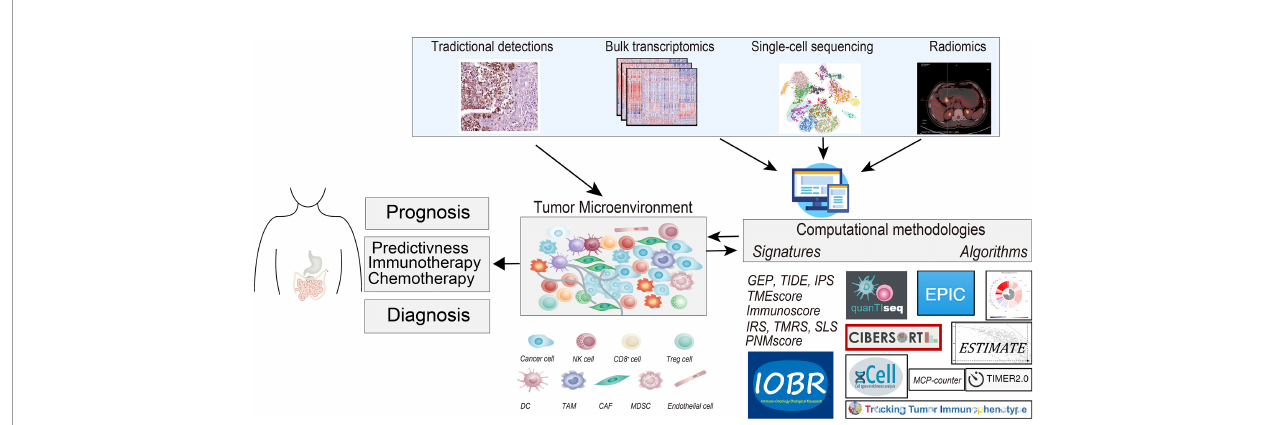
FIGURE 1 | The graphical abstract depicts the tumor microenvironment (TME) in gastrointestinal cancer, outlines the methodologies for deciphering TME compartments, and elucidates the existing TME-relevant biomarkers in the prognostic, chemotherapeutic, and immunotherapeutic settings. Methods for TME assessment comprised the immunohistochemistry (IHC), the computational toolbox for NGS-based analyses, and radiomics detections. NK cell, natural killer cell; Treg cell, regulatory T cells; DC, dendritic cell; TAM, tumor-associated macrophages; CAF, cancer-associated fi broblasts; MDSC, myeloid-derived suppressor cell; NGS, next-generation